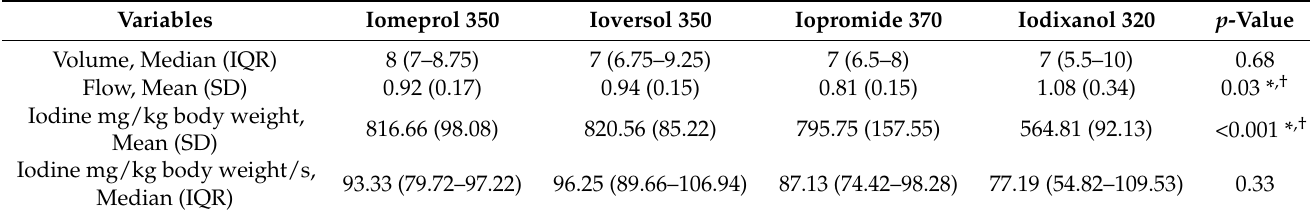
Table 2. Contrast agents data-related parameters.